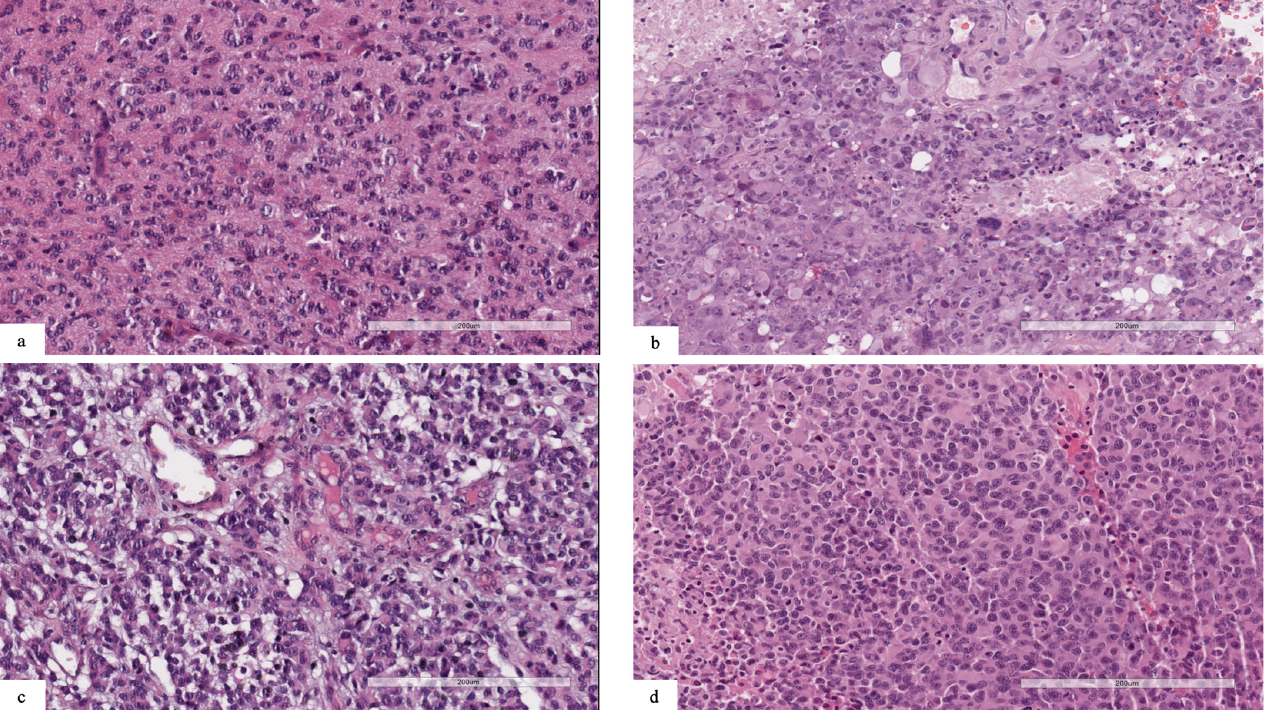
Figure 1. ( a ) Patient #1: neoplasm characterized by high cellularity, nuclear atypia and scant eosinophilic cytoplasm. Mitotic features were present, and necrosis and vascular proliferation were absent. ( b ) Patient #2: tumor composed of spindle, pleomorphic, epithelioid, rhabdoid and xanthomatous morphology. Eosinophilic granular bodies, mitosis (7/10HPF) and necrosis were also present. ( c ) Patient #3: neoplasm with high cellularity, nuclear atypia and scant cytoplasm. Mitotic features and vascular proliferation were present. ( d ) Patient #4: highly cellular tumor, with nuclear pleomorphism and scant eosinophilic cytoplasm. Mitotic features, necrosis and vascular proliferation were present.